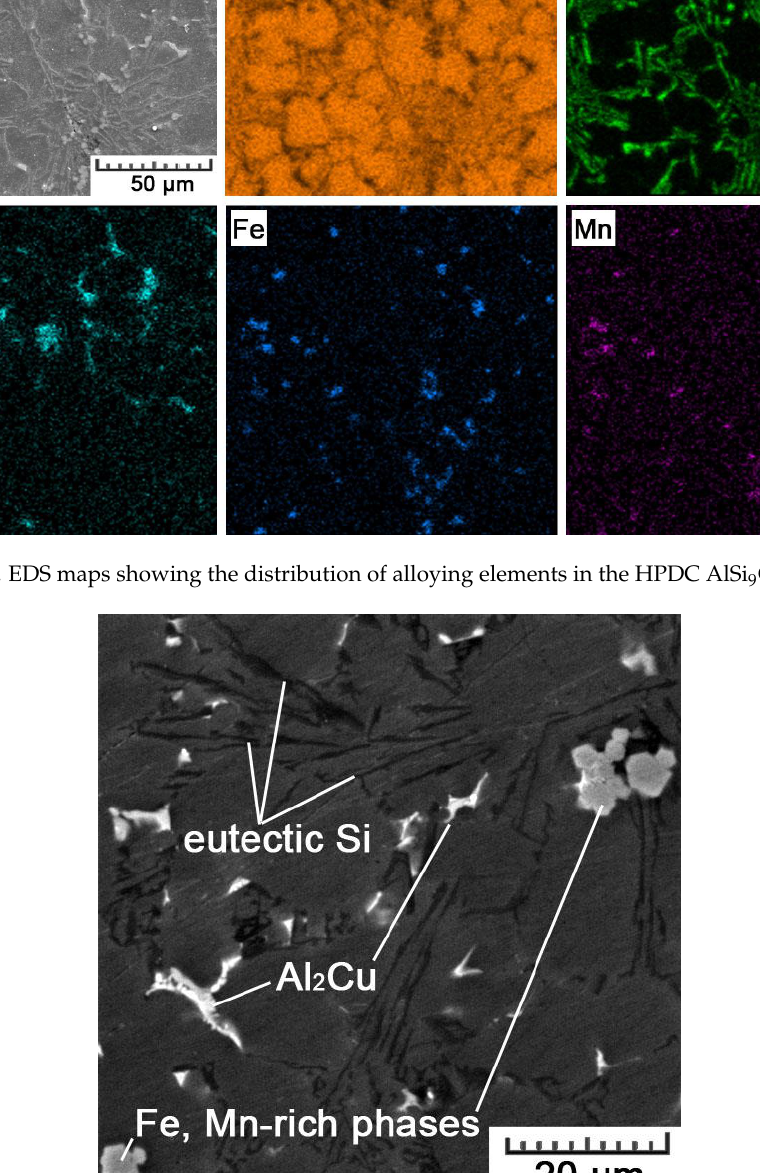
Figure 12. SEM image showing different types of phases in the HPDC AlSi 9 Cu 3 Fe alloy. Table 4. Chemical composition (at.%) of different types of phases in the HPDC AlSi 9 Cu 3 Fe alloy (Figure 12).